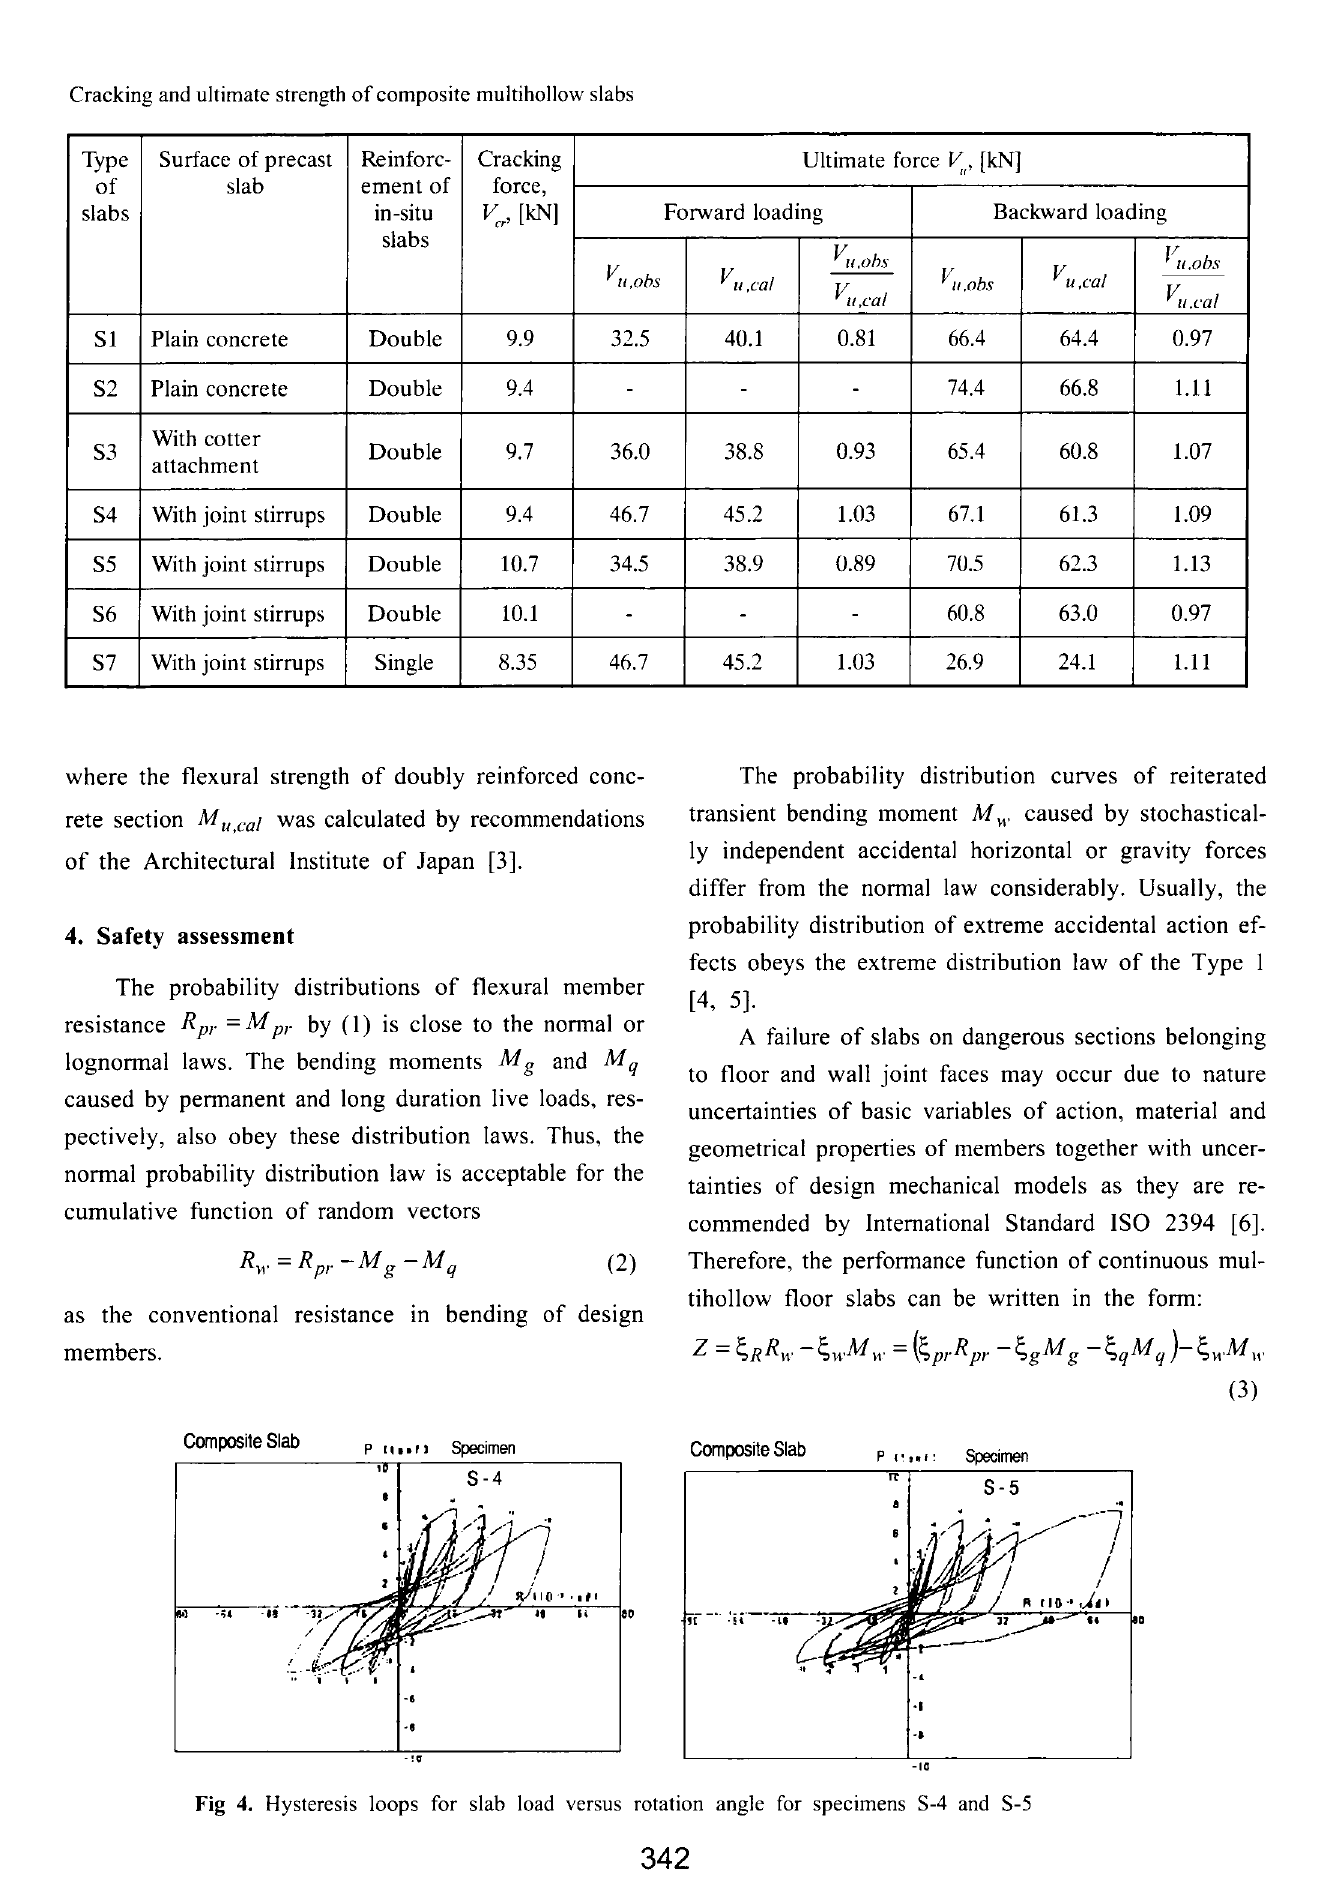
Fig 4. Hysteresis loops for slab load versus rotation angle for specimens S-4 and